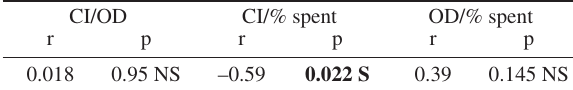
Table 1. – Results of correlations (Spearman coefficient) between the descriptors of the reproductive cycle of A. tuberculata in M’diq Bay. The variances of the statistical test and those of the probability are mentioned [NS :(P>0.05);